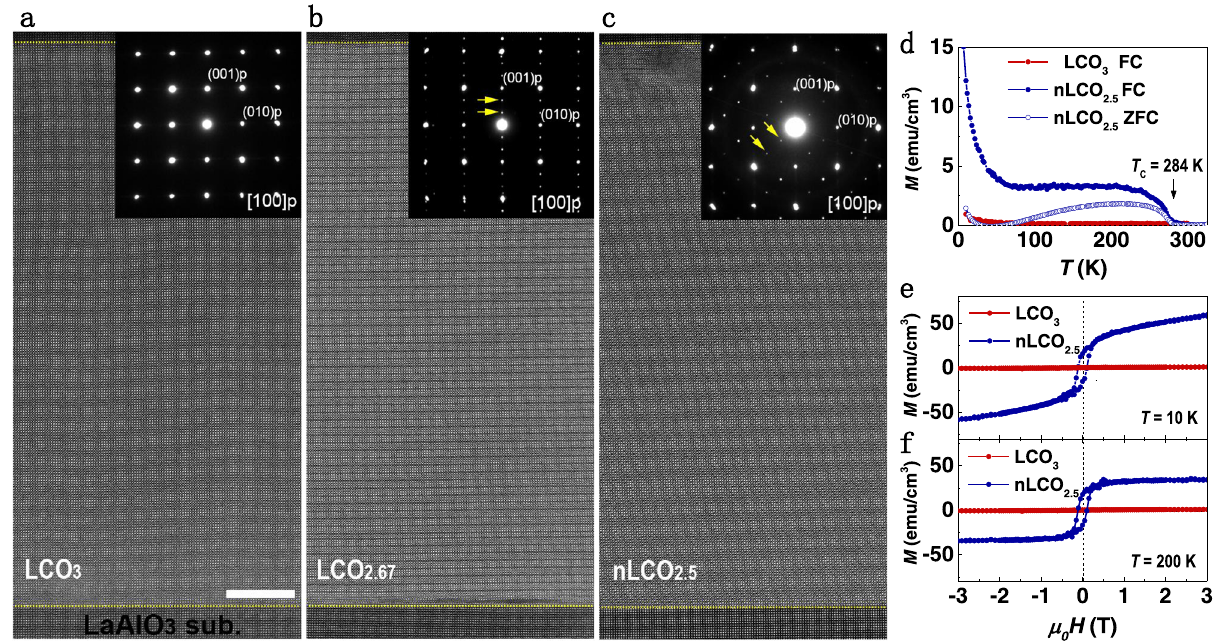
Fig. 1 Structural evolution and magnetic properties of LCO fi lms during anneal process. Low magni fi cation high-angle angular dark- fi eld (HAADF) images of a pristine LCO 3 , b LCO 2.67 , and c nLCO 2.5 fi lms grown on LAO substrates. The corresponding selected-area electron diffraction (SAED) patterns are inserted on the right top corner of each panel, where the yellow arrows indicate the positions of superstructure spots. The white bar represents 10 nm in scale. d M-T curves of LCO 3 and nLCO 2.5 fi lms. The measurements were carried out during the sample warm-up under a magnetic fi eld of 0.1 T. Solid and open symbols represent the fi eld-cooled (FC) and zero- fi eld-cooled (ZFC) data, respectively. e , f M-H curves of LCO 3 and nLCO 2.5 fi lms at 10 and 200 K,